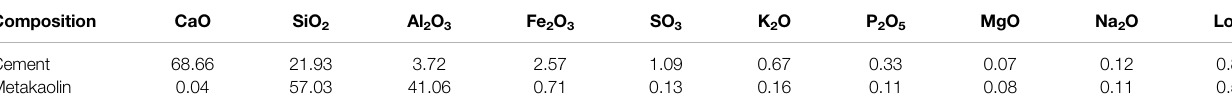
TABLE 1 | Cement and metakaolin chemical composition (%).